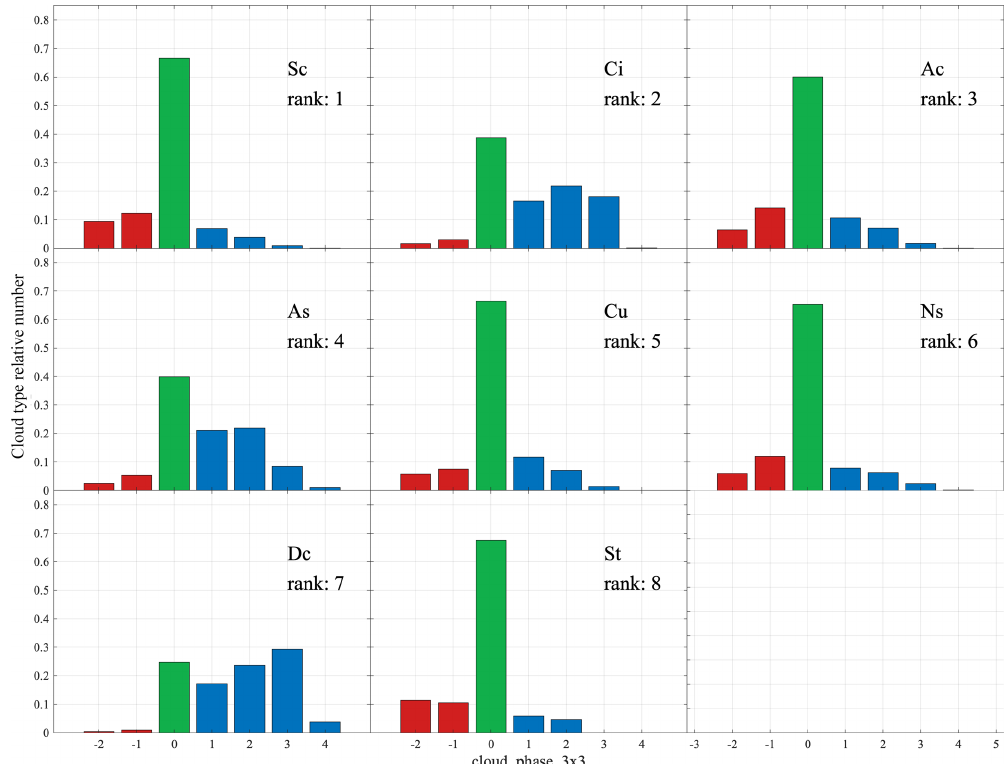
Figure 8. AIRS cloud_phase_3x3 histograms for partly cloudy sky with one cloud type. All else equal to Fig. 7.